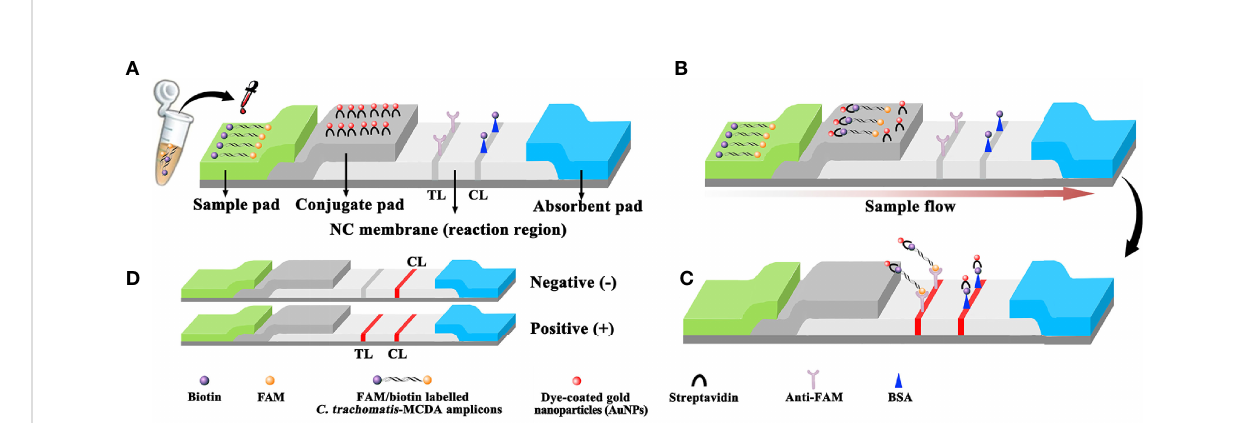
FIGURE 2 Schematic diagram showing AuNPs-LFB principles for the visual identi fi cation of C trachomatis -MCDA ampli fi cation products. (A) C trachomatis -MCDA ampli fi cation products (0.5 m l) and running buffer (100 m l) were simultaneously added to the sample pad. (B) Due to capillary action, the running buffer, containing (C) trachomatis -MCDA products, moved forward onto the conjugate pad and nitrocellulose (NC) membrane. Streptavidin-AuNPs were hydrated, rapidly released, and combined with C trachomatis -MCDA products at the conjugate pad. (C) FAM/biotin-labeled C trachomatis -MCDA products were arrested by anti-FAM at the TL strip, and streptavidin-DPNs were arrested at the biotin-BSA CL strip. (D) Interpretation of the C trachomatis -AuNP-LFB assay. For a positive result, both the CL and TL appeared on the biosensor. For a negative result, only the CL was observed on the AuNP-LFB. TL: test line; CL: control line.